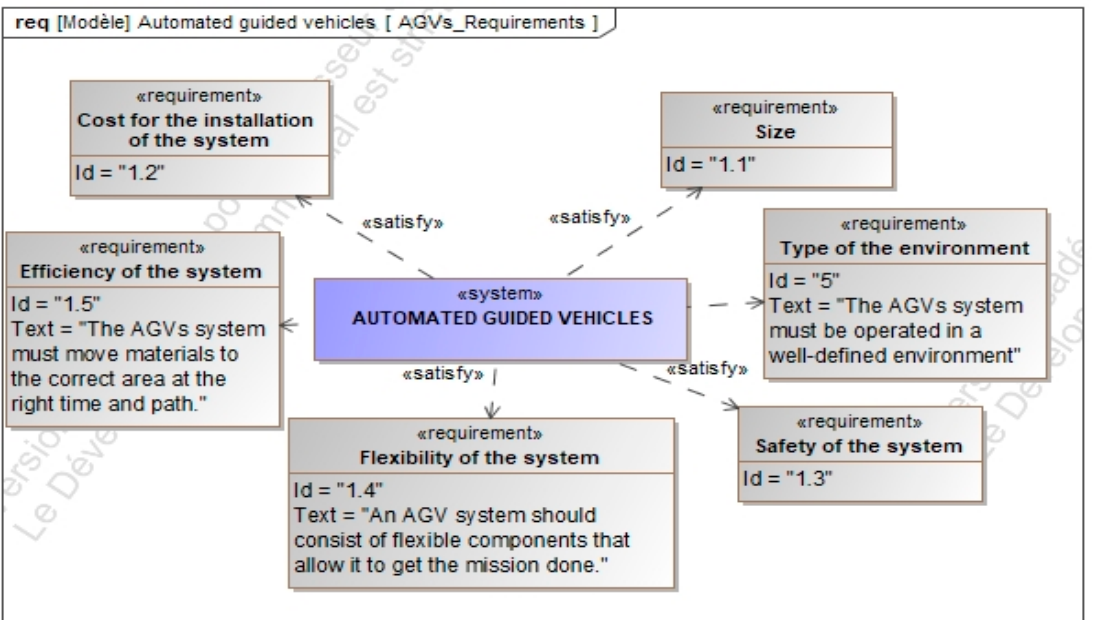
Figure 10. Requirement diagram of automatically guided vehicles (AGV) in SysML.